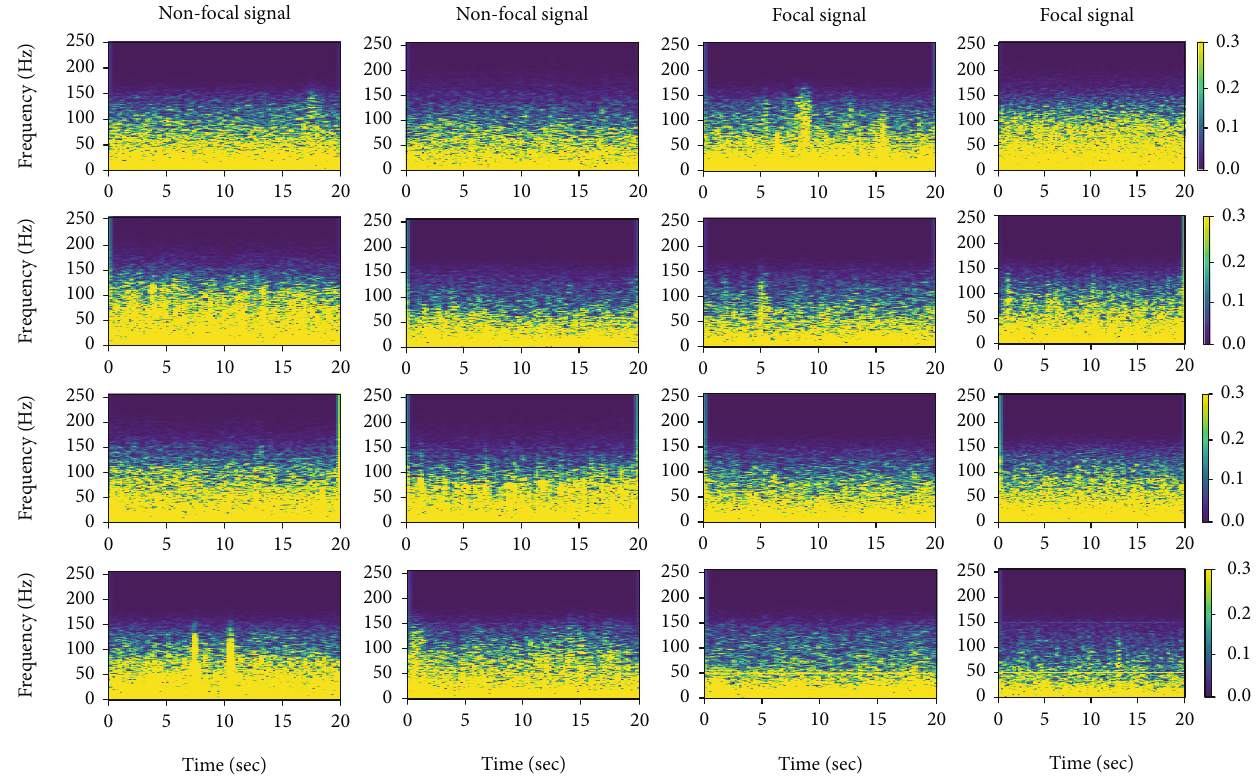
Figure 2: STFT of the focal and nonfocal iEEG